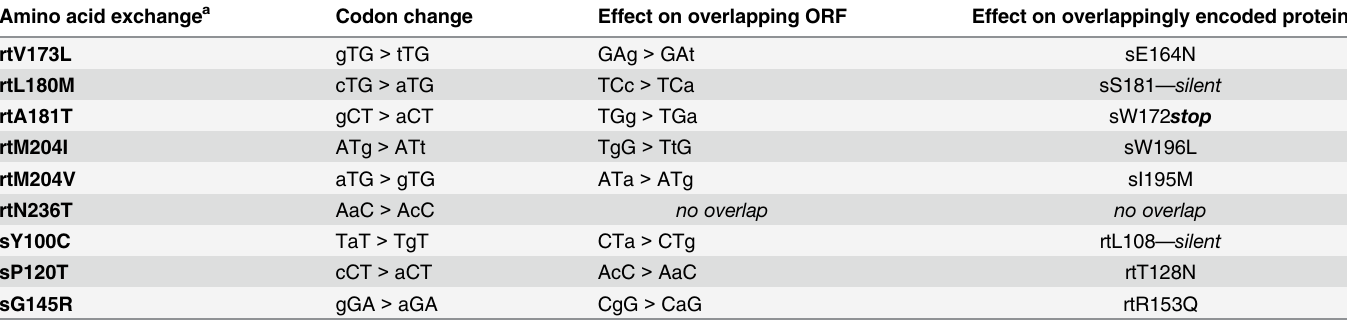
Table 1. Amino acid and underlying nucleotide exchanges in the polymerase and S protein, and their effects on the overlapping ORF and encoded protein. Amino acid exchange a Codon change Effect on overlapping ORF Effect on overlappingly encoded protein